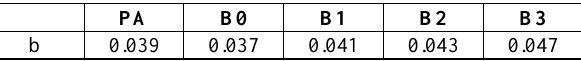
Table 4. Estimation of b (assessed April 5, 2012).